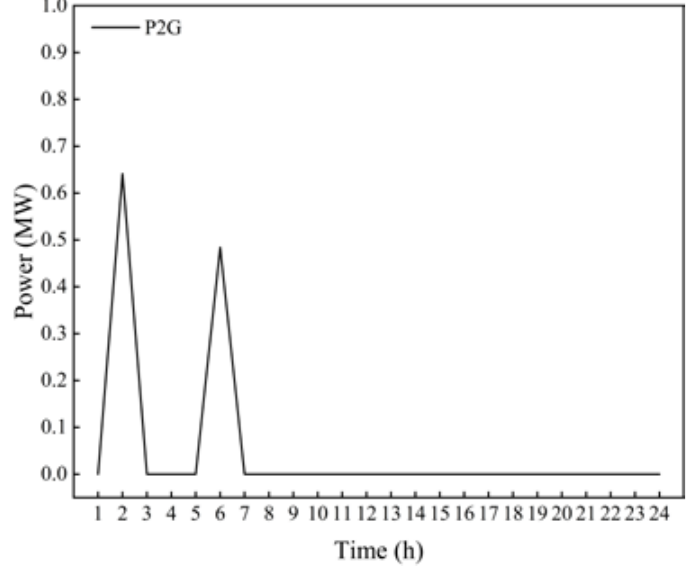
Figure 8. PIES 4 P2G facility consumption.